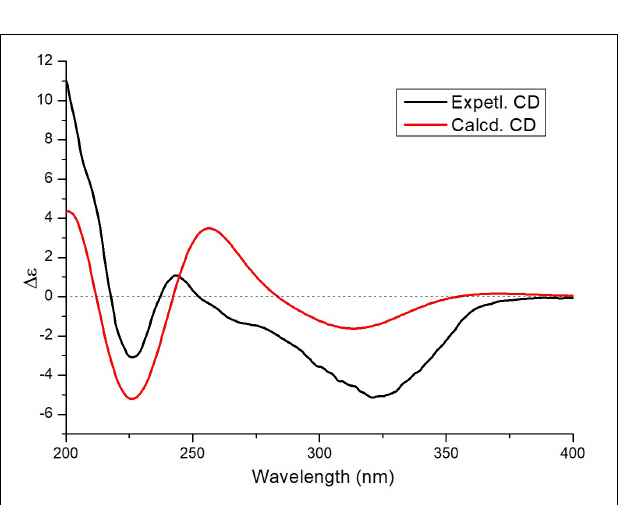
FIGURE 4 | Experimental and theoretical ECD spectra of compound 3